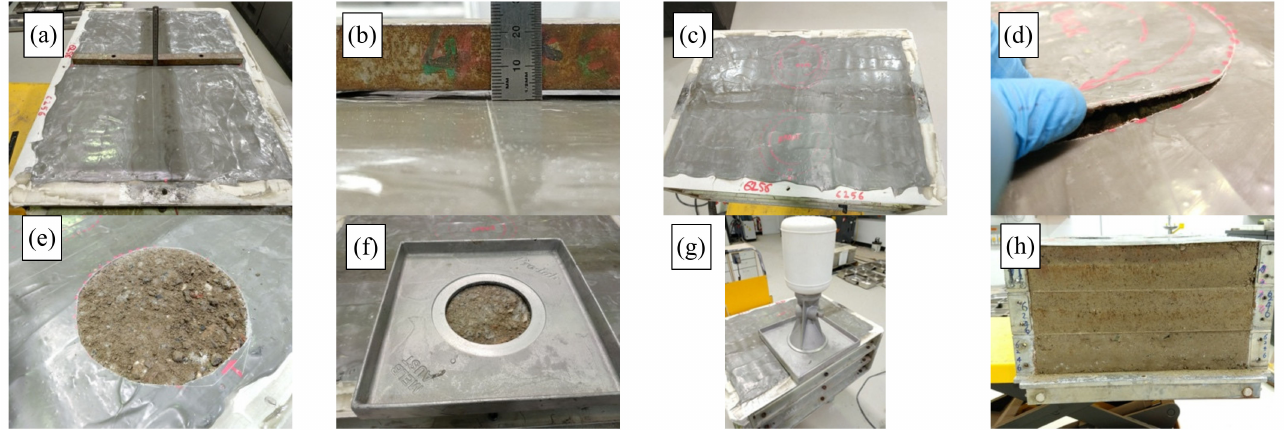
Figure 9. Post WT test rutting and density measurements. ( a ) after test, ( b ) final rut measurement, ( c ) after test specimen, ( d ), ( e , f ) sampling after test, ( g ) density check and ( h ) layers after